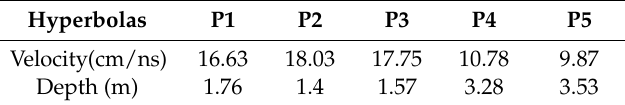
Figure 10. Interpretation of the lunar penetrating radar (LPR) data from N104 to N105. Table 1. The estimated velocities and depths of the